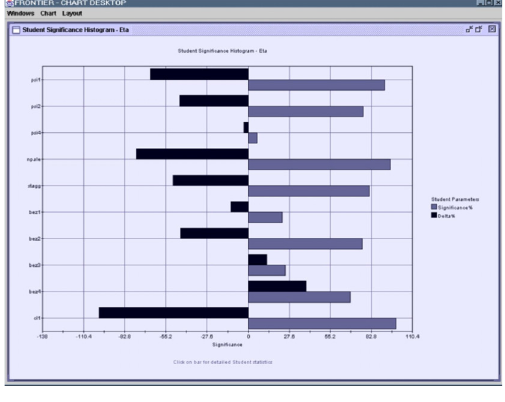
Figure 6: Course of the fitness function in the third optimization